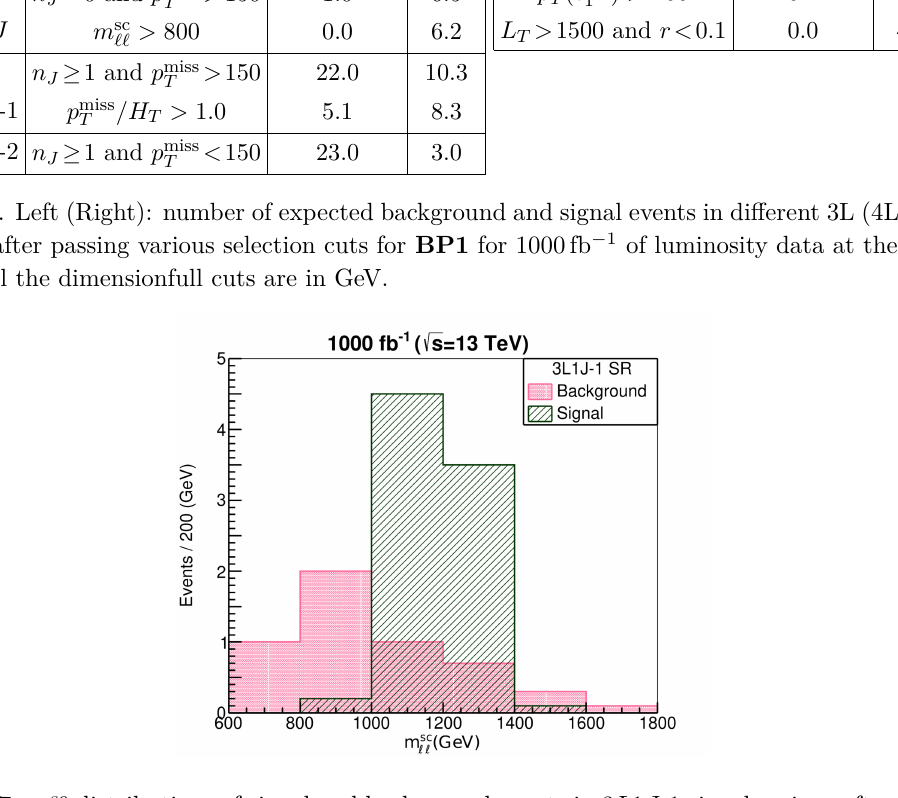
Figure 7 . m sc distributions of signal and background events in 3 L 1 J -1 signal regions after passing ‘‘ various selection cuts for BP1 for 1000 fb − 1 of luminosity data at the 13 TeV